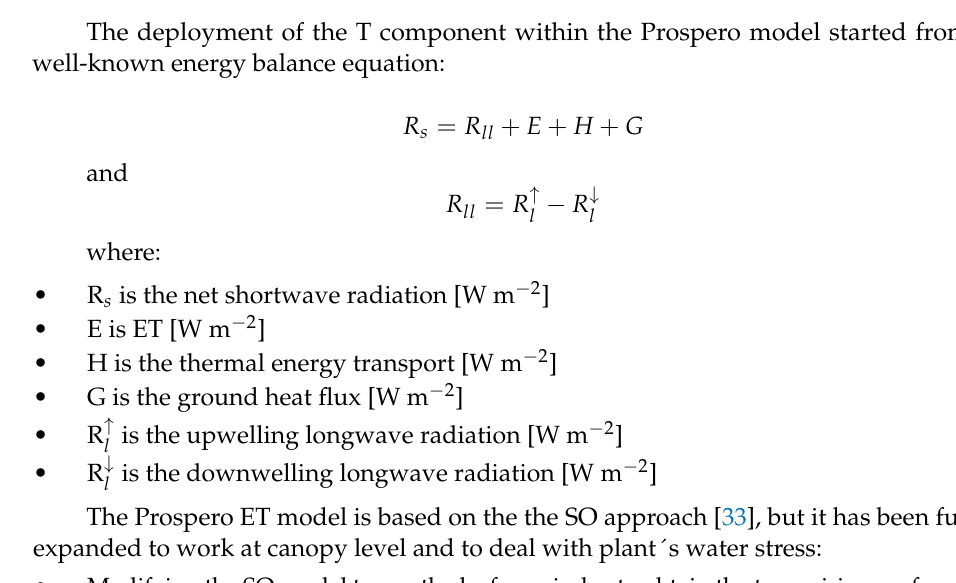
Figure 3. Conceptual scheme of the GEOframe-Prospero